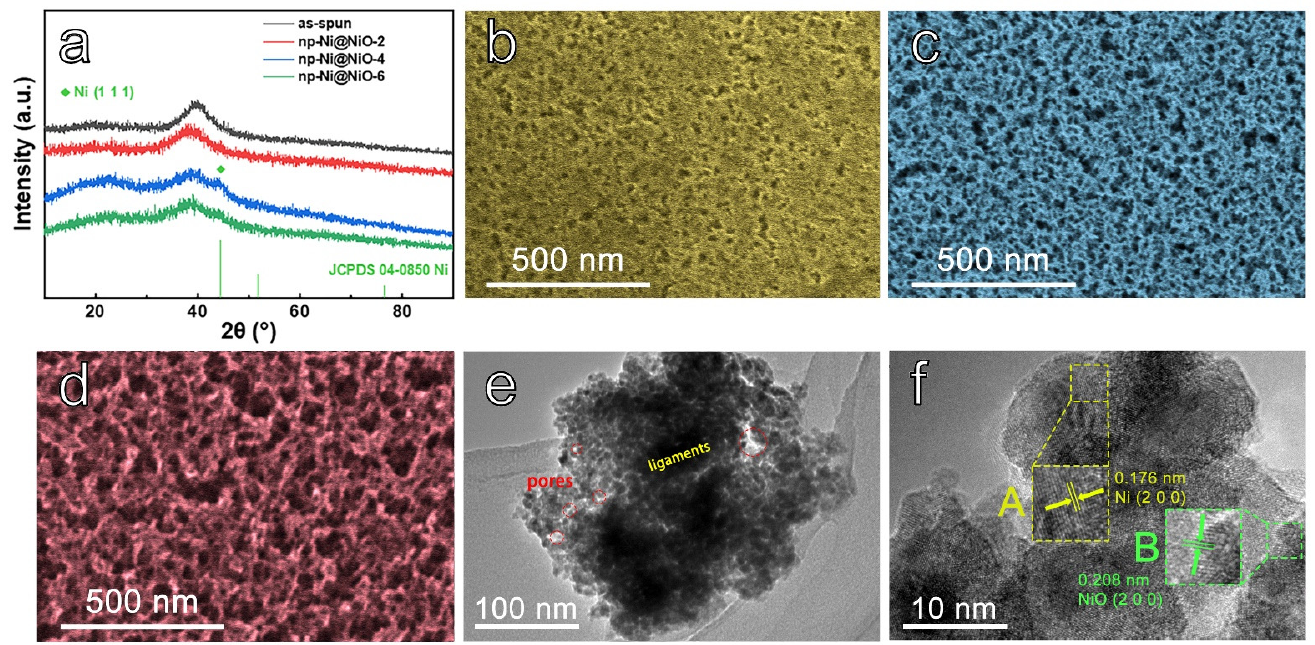
Figure 1. ( a ) XRD patterns of as ‐ spun Ni 40 Ti 40 Zr 20 and as ‐ dealloyed samples. SEM images of the as ‐ spun samples immersed in 0.05 M HF at 298 K for ( b ) 2 h; ( c ) 4 h and ( d ) 6 h. ( e ) TEM image and ( f ) corresponding HRTEM image of np ‐ Ni@NiO ‐ 4.